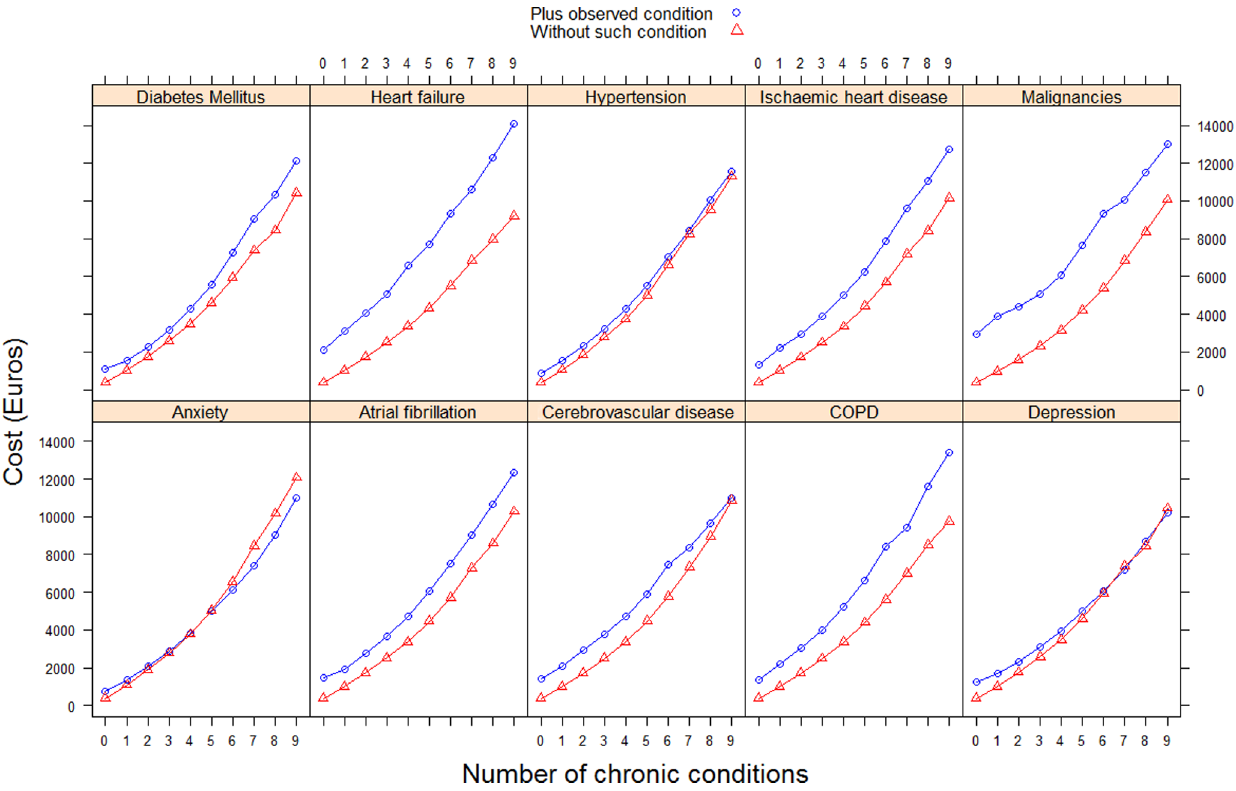
Figure 1. Difference in average of adjusted annual cost (in euros) per patient, by number of coexisting chronic diseases according to the presence of certain selected diseases.